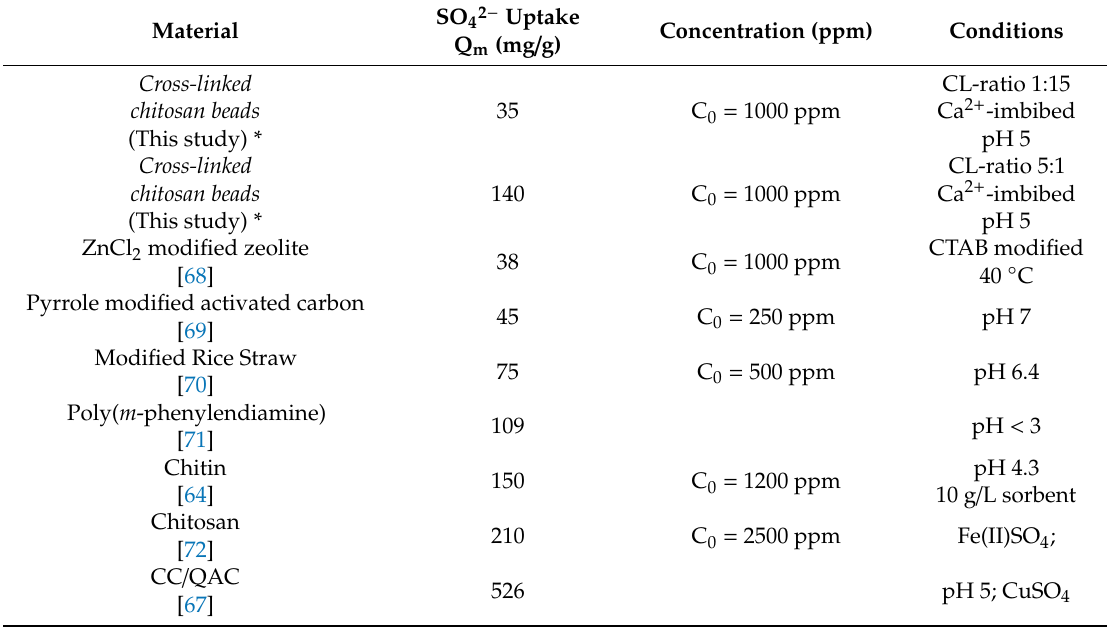
Table 2. Literature comparison of the sulfate monolayer uptake capacity (Q m ) values for di ff erent sorbent materials and results from this